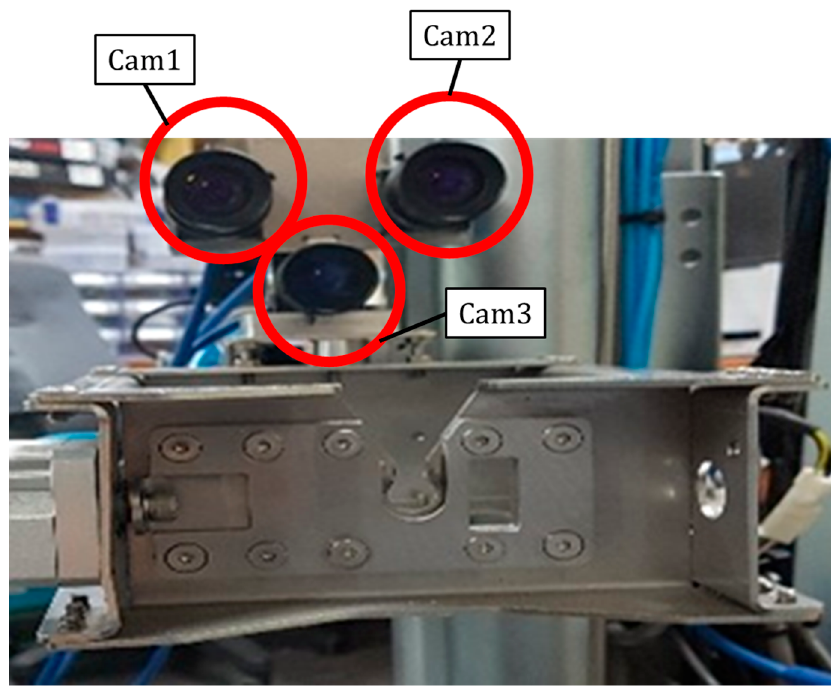
Figure 5. Three cameras used in the vision servo system.